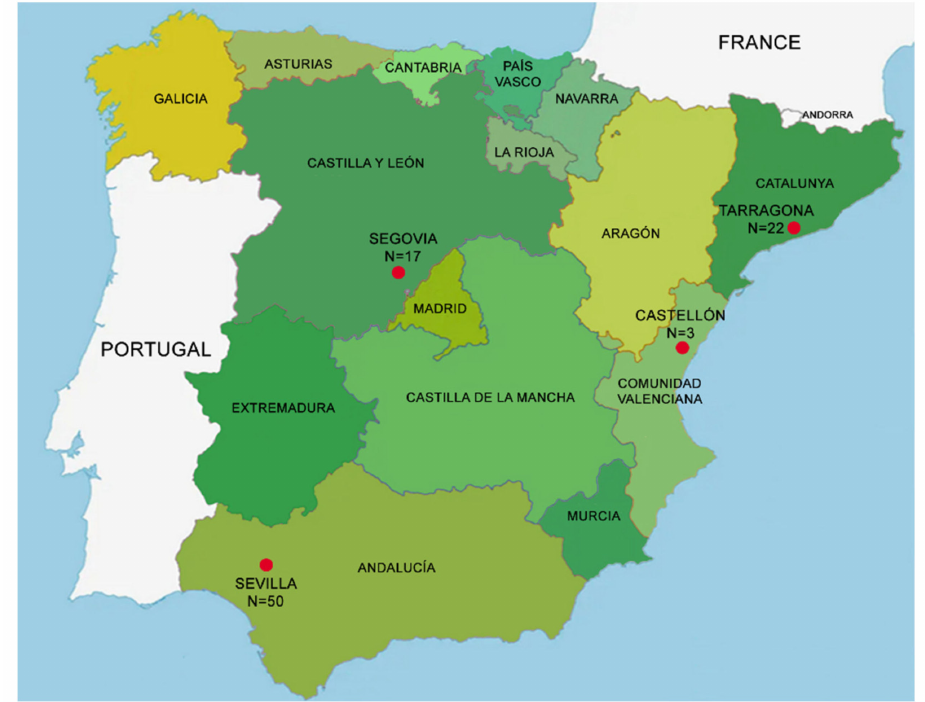
Figure 1. Sampling locations